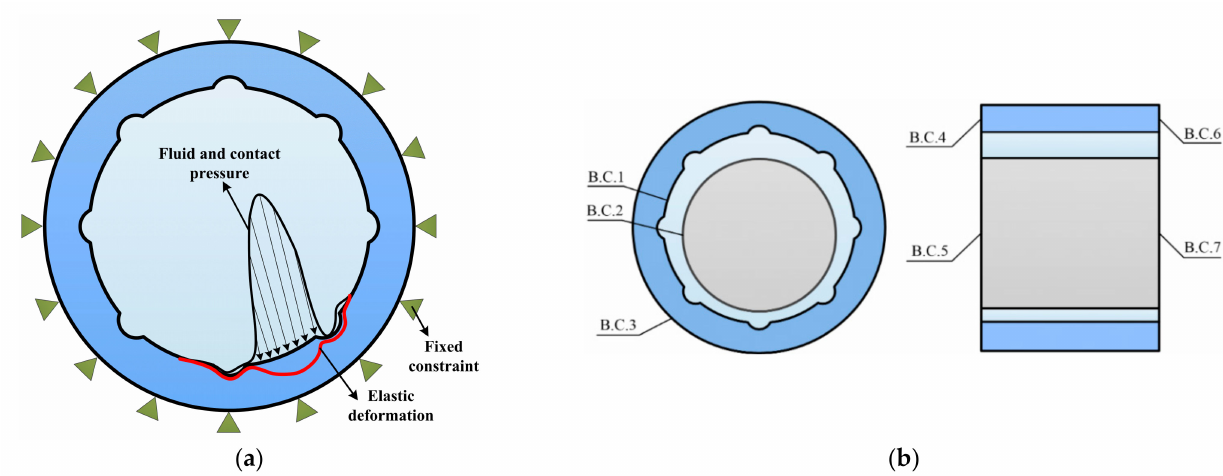
Figure 5. Boundary conditions for ( a ) elastic deformation and ( b ) the thermal analysis.